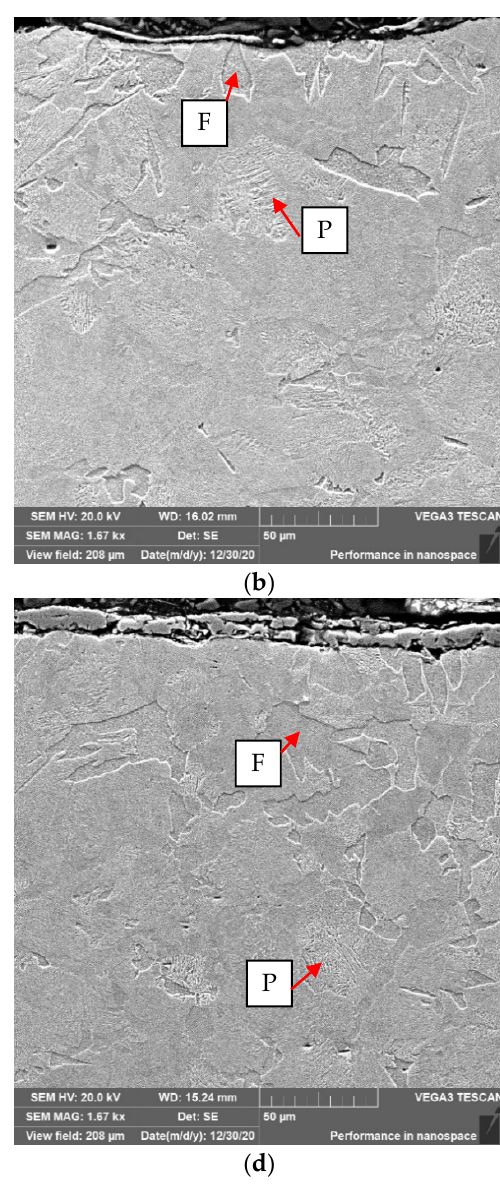
Figure 12. Microstructure in the surface layer of the forged part after hot forging and cooling— pre-coating in Condursal in concentration of 100%.